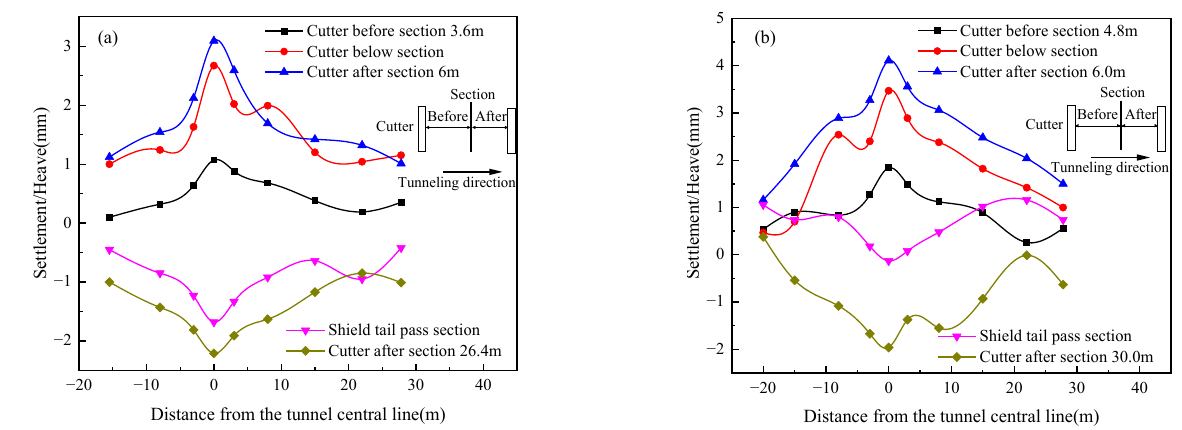
Figure 5. Surface section deformation of the south line: ( a ) SSP-S-330; ( b ) SSP-S-350.